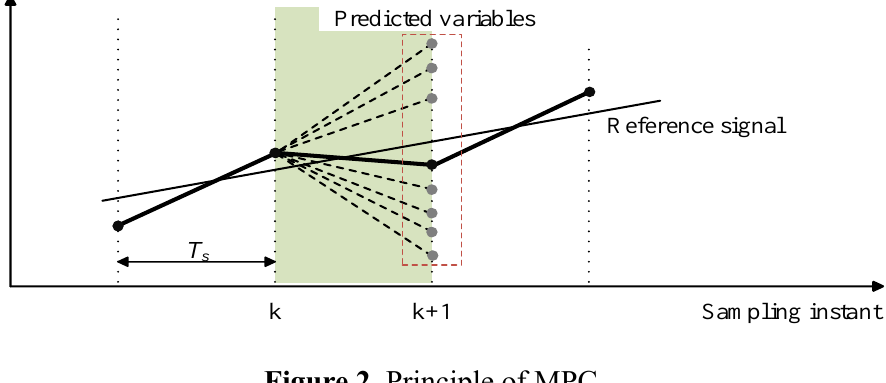
Figure 2. Principle of